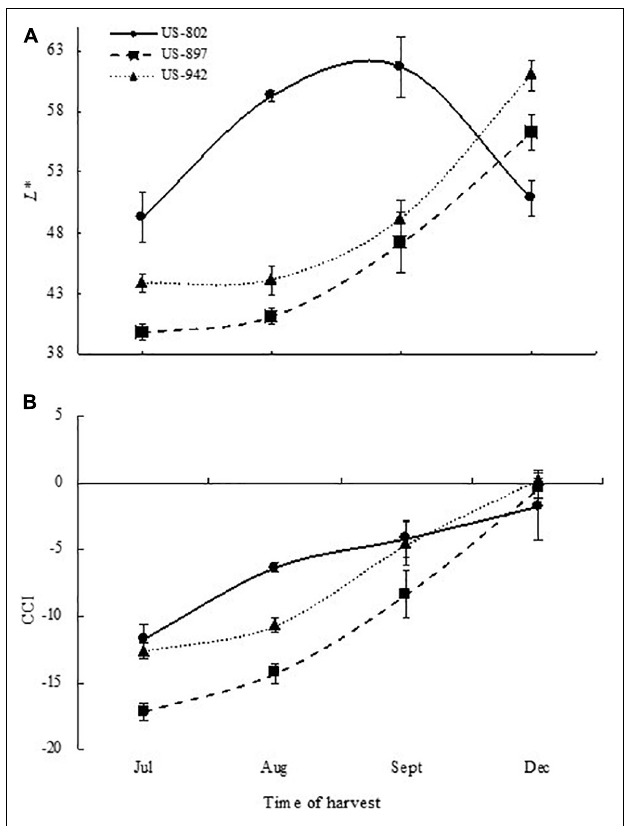
FIGURE 3 | Flavedo color development of citrus rootstock fruits during different harvest periods: Lightness ( L ∗ ) (A) and citrus color index (CCI) (B) .